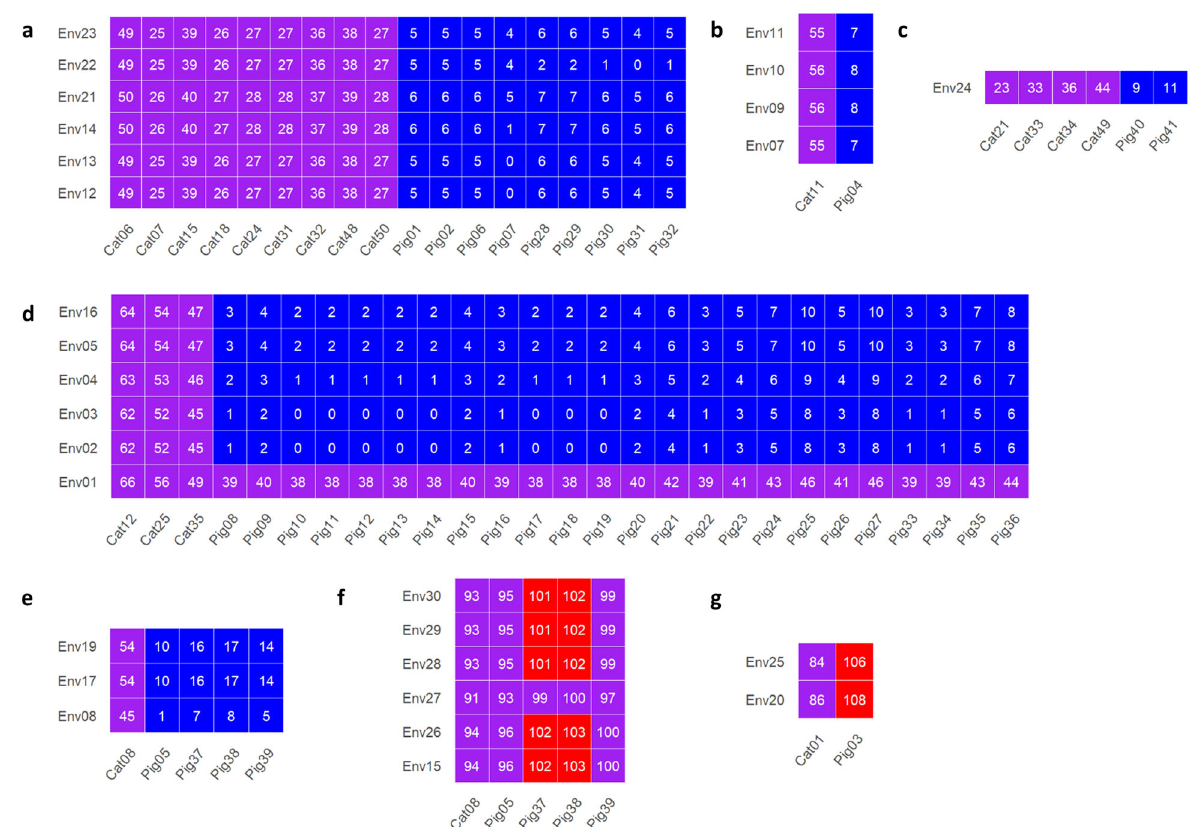
Fig. 5 The SNP distance of environmental isolates of each phylogenetic group with their closest cattle and pig isolates. a – g shows the environmental isolates of group 1 – 7, respectively. The SNP distances are coded with blue, purple, and red representing <21 SNPs, ≥ 21 SNPs and ≤ 100 SNP, and >100 SNPs,